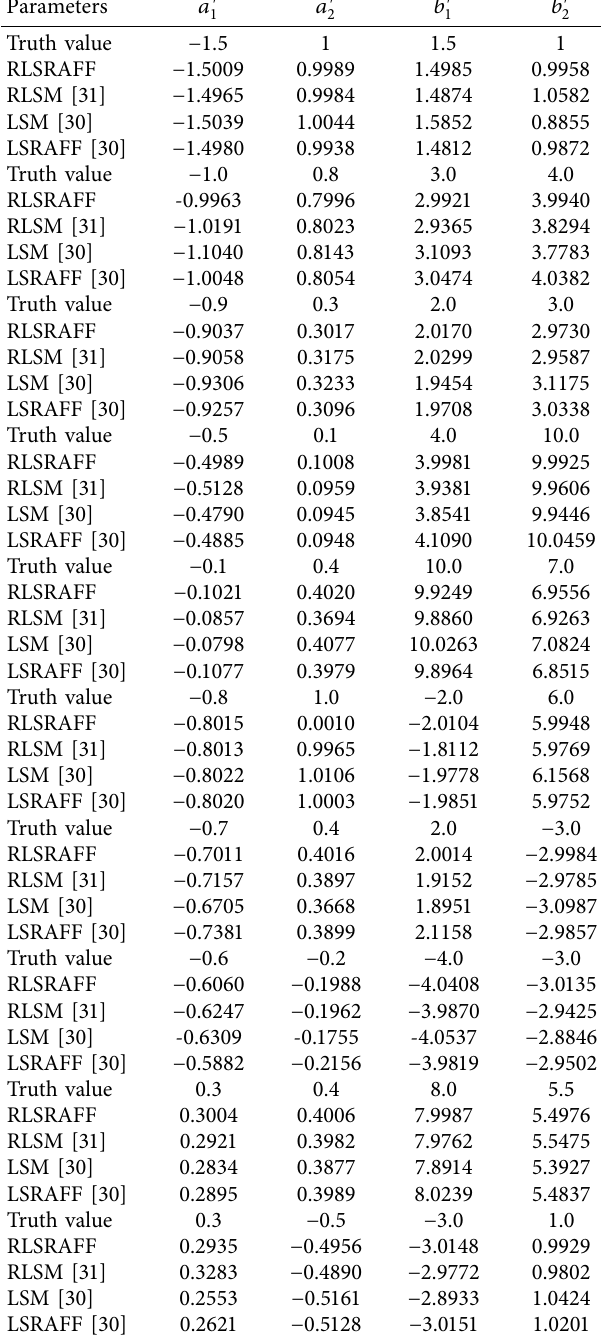
Table 4: Identification results of 10 experiments. Table 3: The average and maximum relative error between the